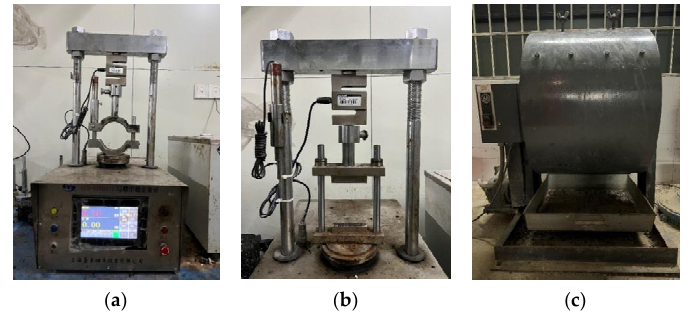
Figure 3. ( a ) Marshall stability test; ( b ) tensile strength test; ( c ) Cantabro test.